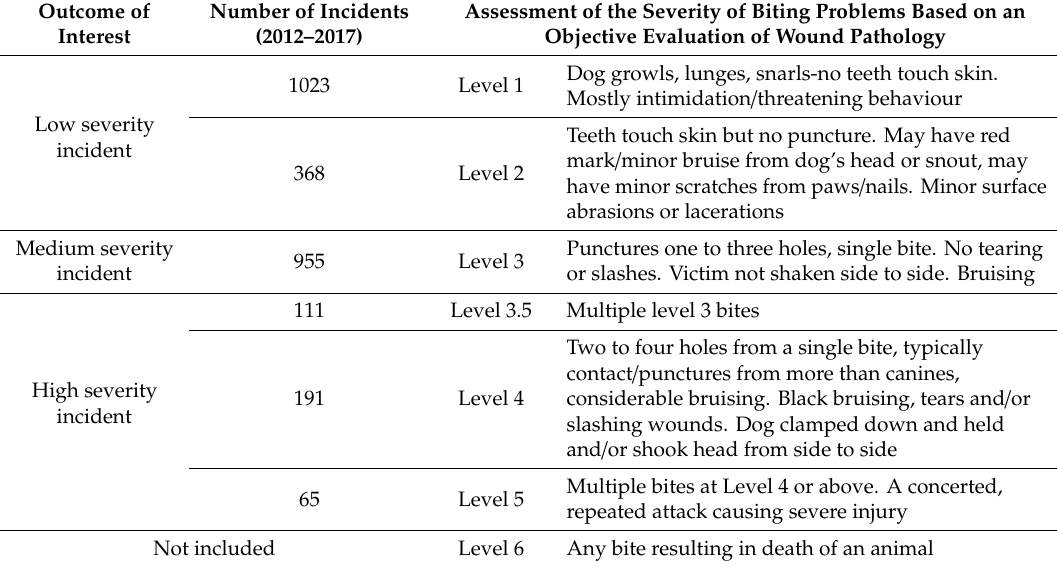
Table 1. The Dr. Ian Dunbar aggression assessment scale modified by Dr. Dunbar and Calgary Animal Services in